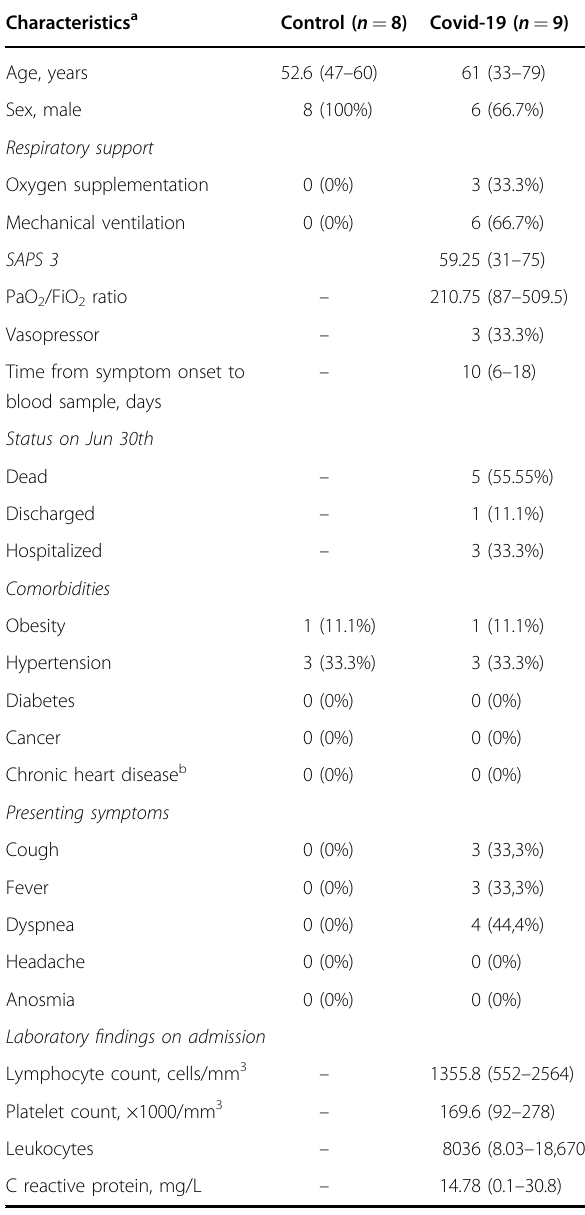
Table 1 Characteristics of COVID-19 patients and control